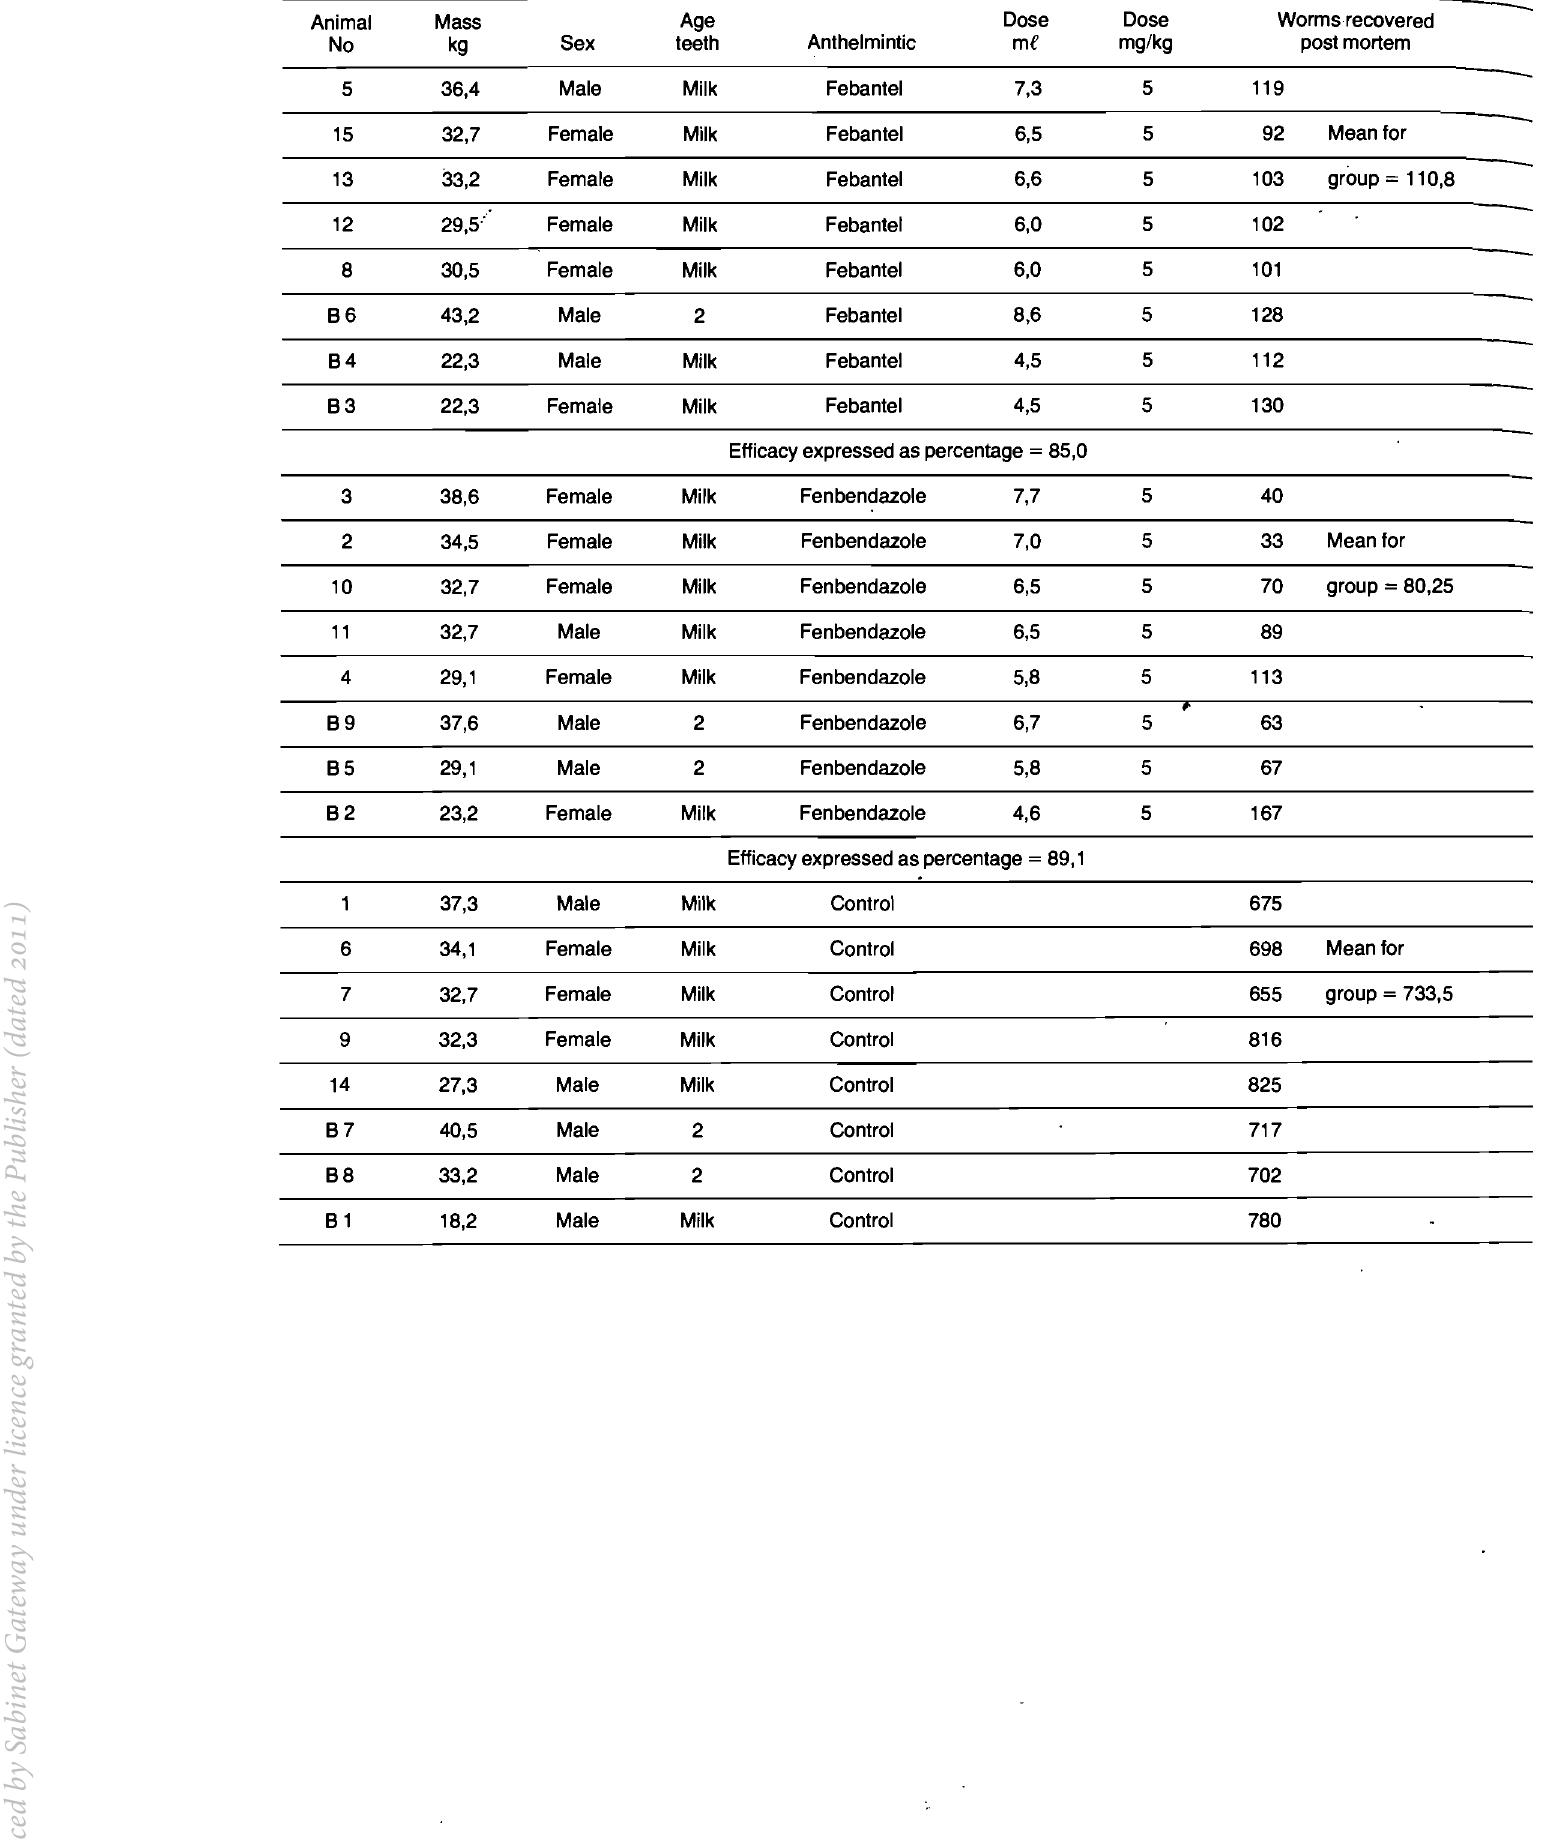
Table 1: EFFICACY OF FE8ANTEL AND FEN8ENDAZOLE AGAINST S. papil/osus -